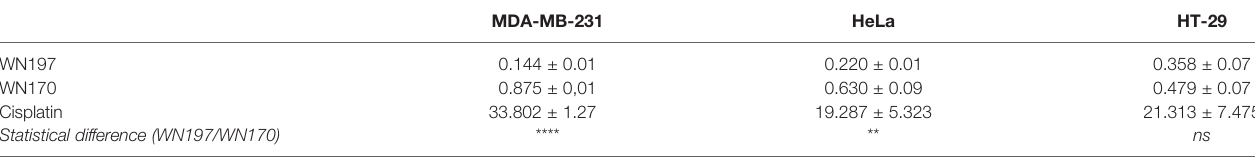
TABLE 1 | Half maximal inhibitory concentrations (IC 50 in m M) for cell survival.